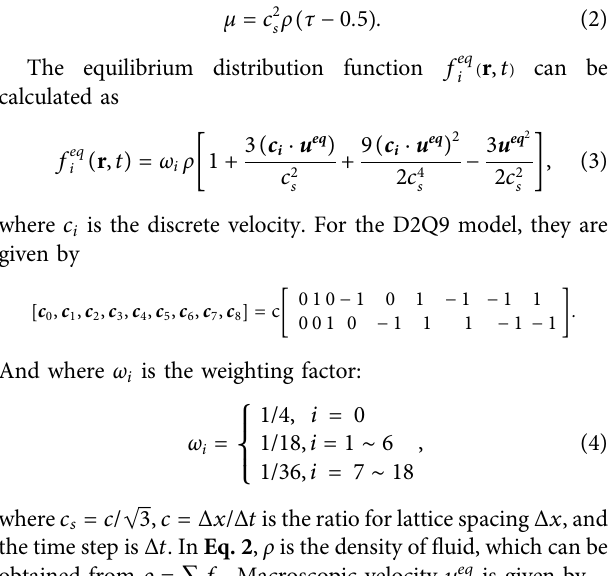
Frontiers in Earth Science |